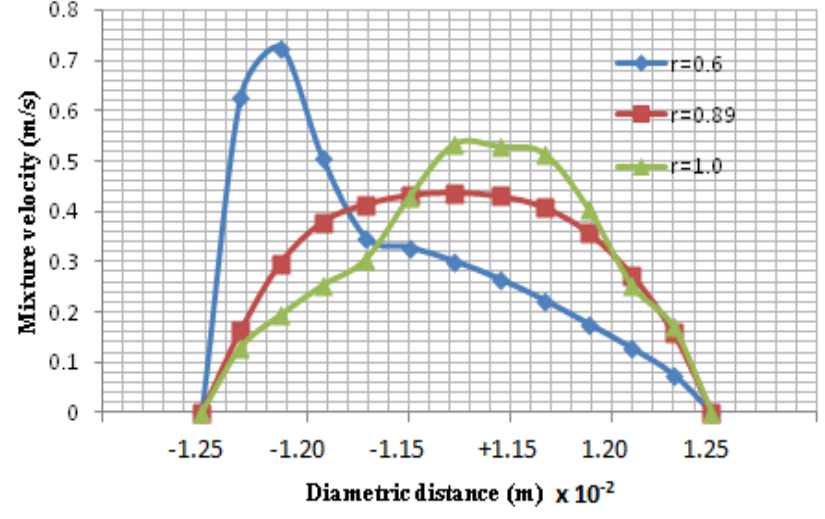
Figure 5. Density ratio affecting the diametric variation of mixture